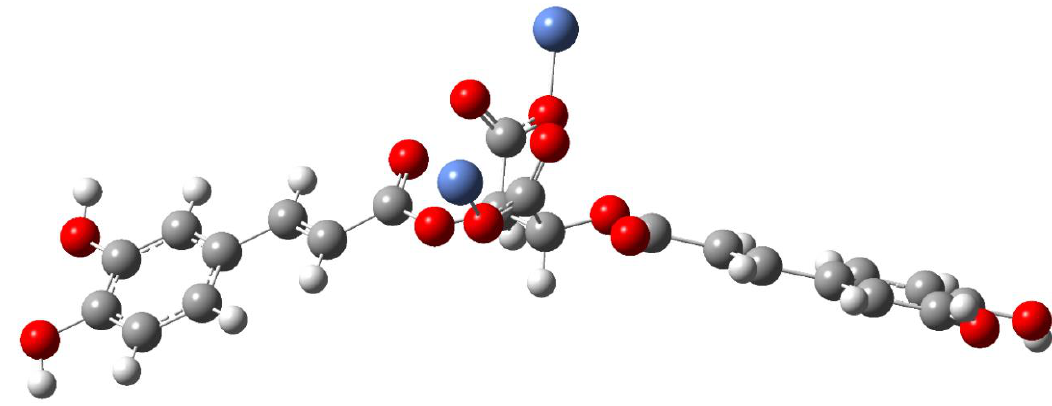
Figure 4. The proposed structures of nickel and zinc cichoriate structures.